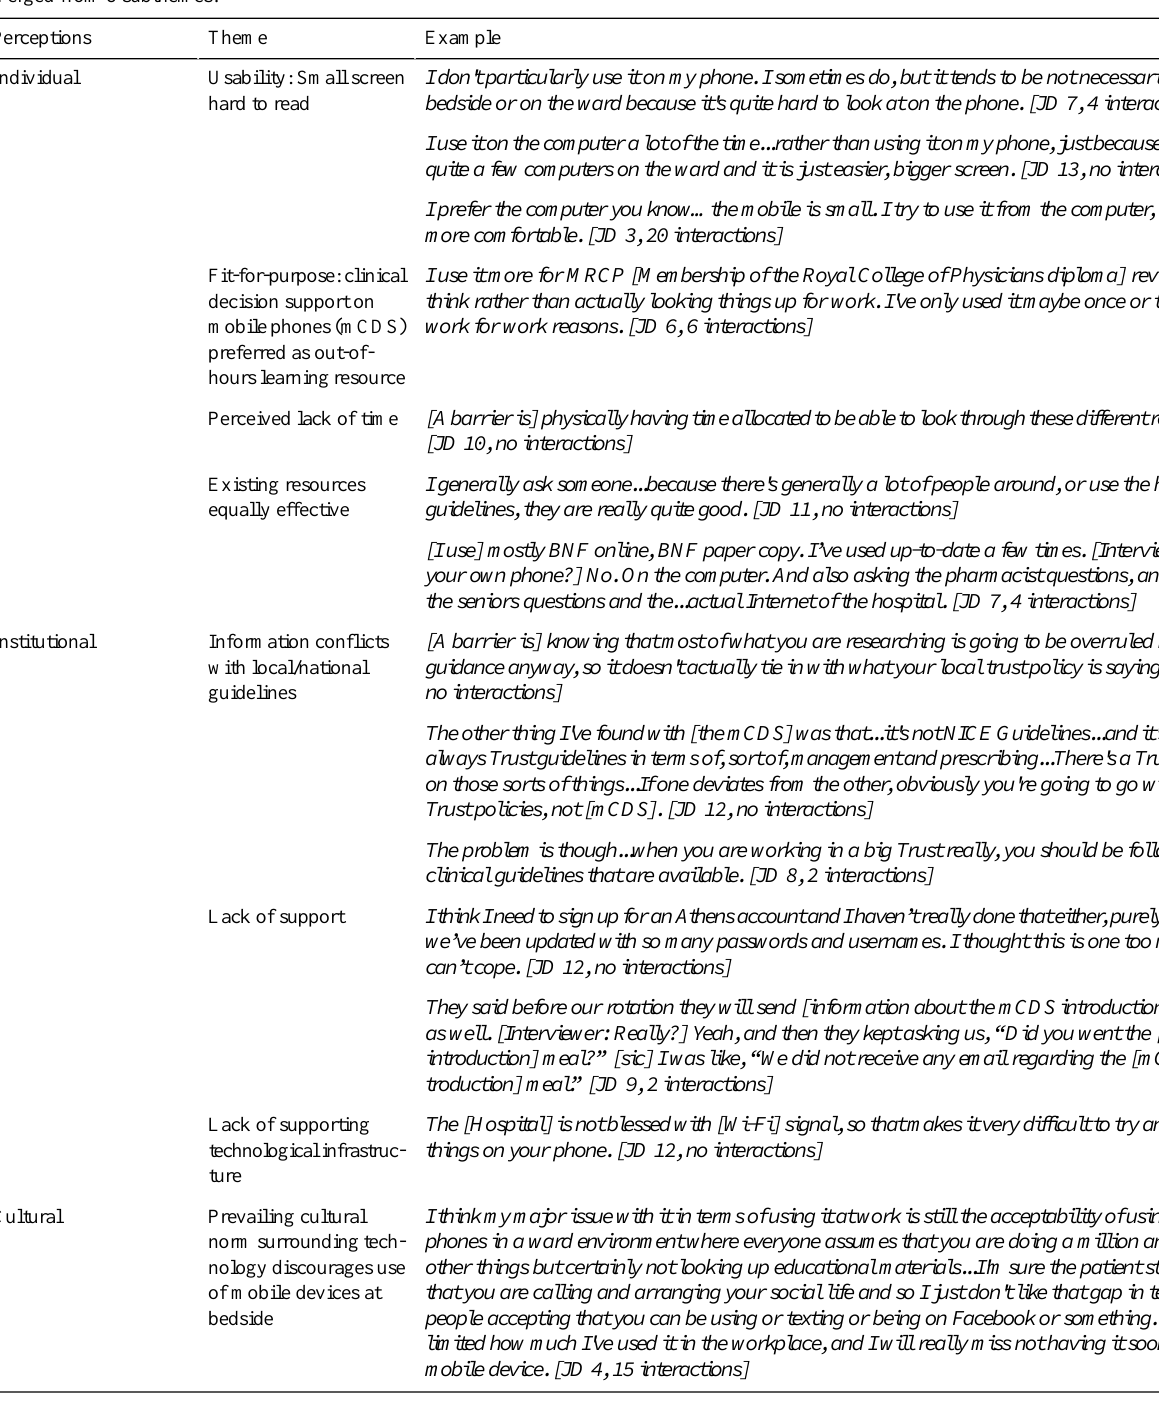
Table 4. Individual, institutional, and cultural perceptions to explain the engagement with clinical decision support on mobile phones. The 3 categories emerged from 8